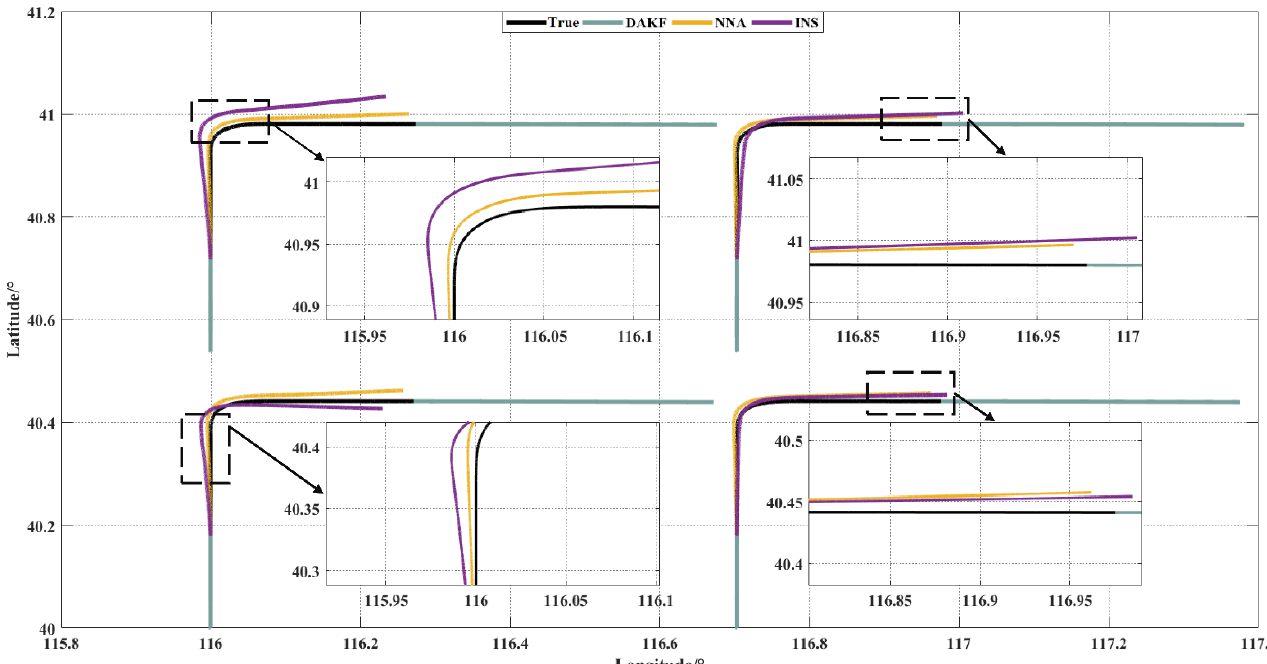
Figure 7. Swarm trajectory in the horizontal direction.